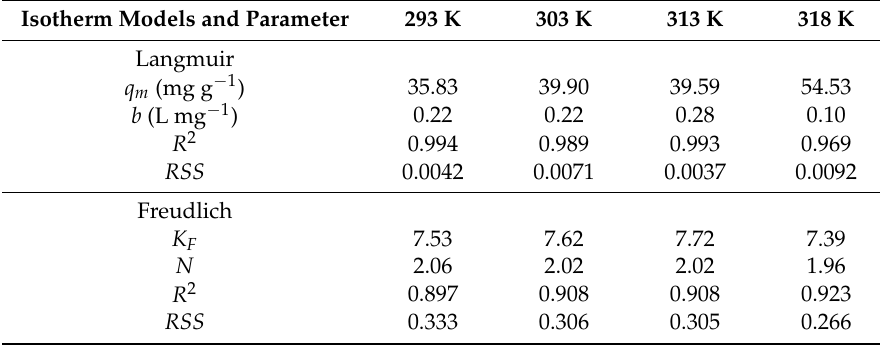
Table 4. Isotherm parameters for the uptake of Zn(II) by adsorption onto MNP-Maph at different temperatures.